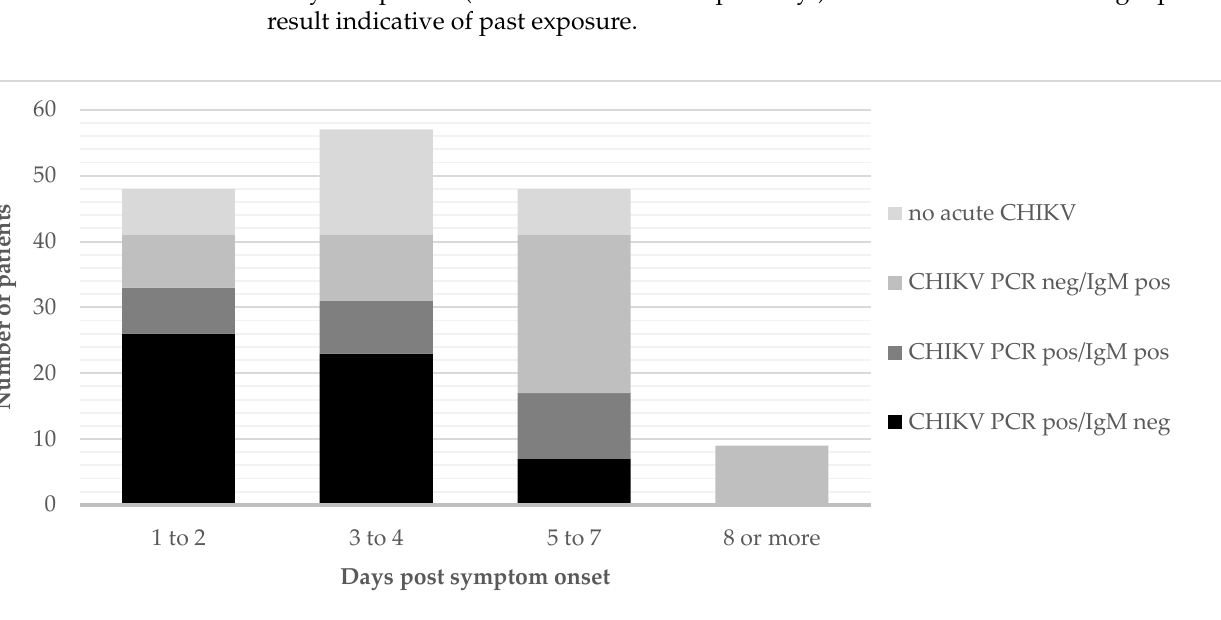
Table 2. Entomological data of the outbreak investigation in Matadi per neighborhood in which Aedes mosquitos were captured.